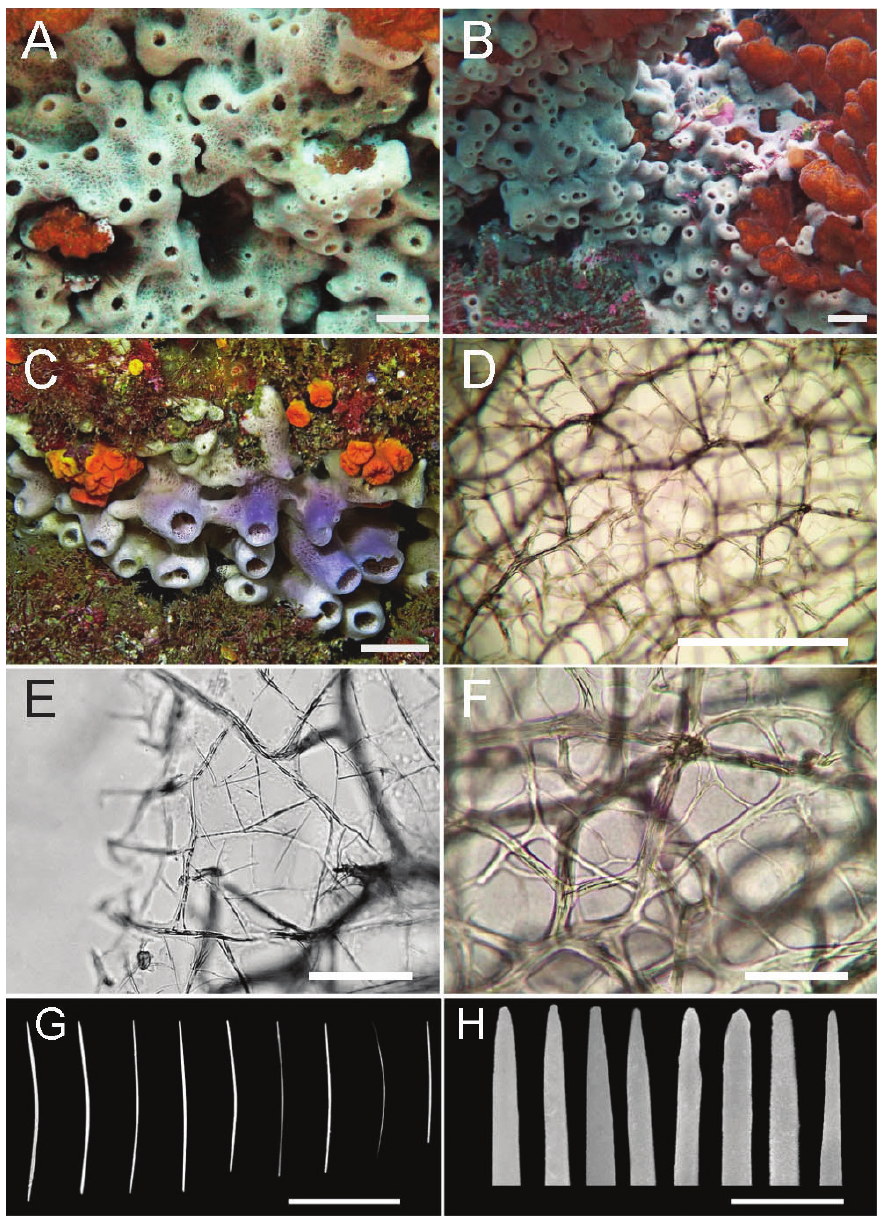
Figure 4. Callyspongia ( Callyspongia ) aff . californica Dickinson, 1945 ( sensu Cruz-Barraza and Carbal- lo 2008) A–C specimens alive in situ: A CENAIM 150820EP02-01 B CENAIM 150813EP07–07 C specimen collected for chemical studies CENAIM 150825EP04-04, of the rarer tubular morphotype D delicate ectosomal reticulation seen through stouter subectosomal polygonal meshes E detail of ec- tosomal reticulation with primary and secondary meshes F detail of subectosomal reticulation showing stouter, multi-spicular tracts G oxeas h details of the terminations of the oxeas. Scale bars: 1.5 cm ( A–C ); 1000 µm ( D ); 400 µm ( E–F ); 50 µm ( G ); 50 µm ( h